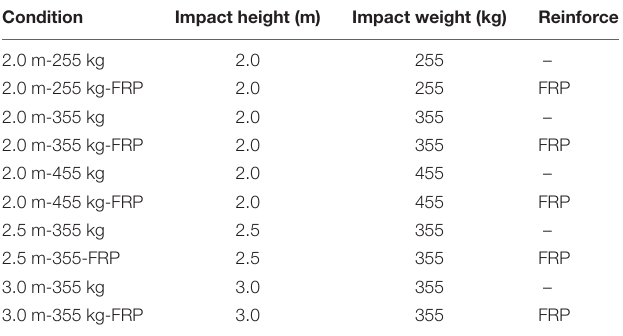
TABLE 3 | Simulation conditions.